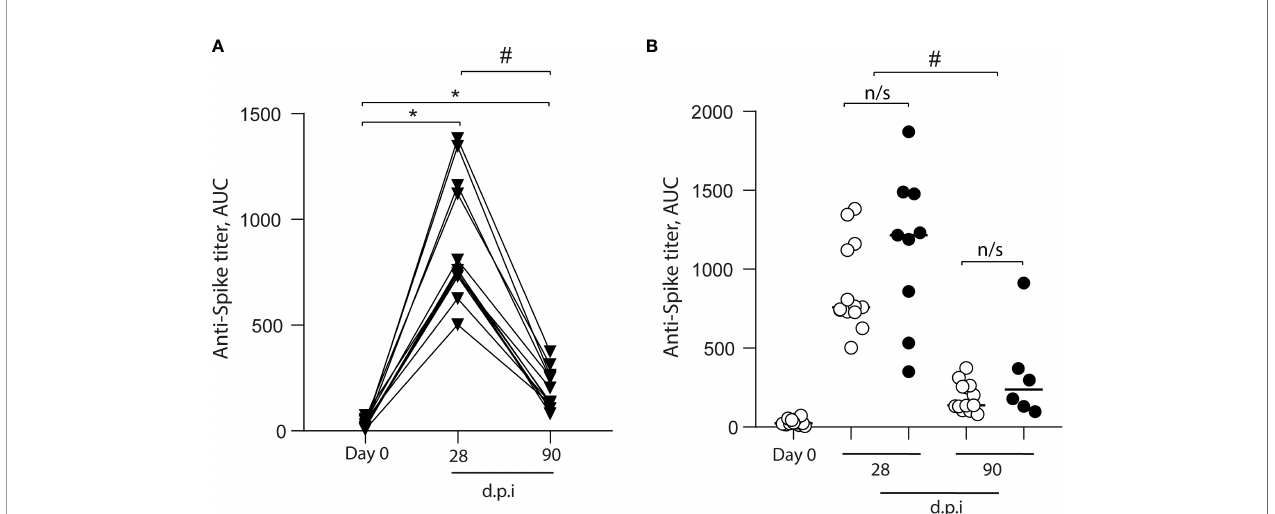
FIGURE 2 | Total anti-S antibodies in the plasma of CoronaVac-vaccinated volunteers. Anti-S antibodies were quanti fi ed in plasma obtained prior to immunization (Day 0), and 28 and 90 days after the second immunization (dpi). (A) Antibody titers are expressed as the area under the ELISA OD curve (AUC) made from four serial dilutions (1/200, 1/400, 1/800, and 1/1600) for each volunteer ( ▾ ). The data show individual paired values. (B) Detail of the antibody titers for the volunteers with complete follow-up ( n = 15) throughout the study (data from A; ○ ), and those with no sample on some of the time points evaluated ( (cid:129) ) were graphed and shown with median. Asterisk (*) represents statistically signi fi cant difference compared to baseline ( p < 0.05). Hashtag (#) represents statistically signi fi cant difference between 28 dpi and 90 dpi samples. n/s, not signi fi cant ( p < 0.05).